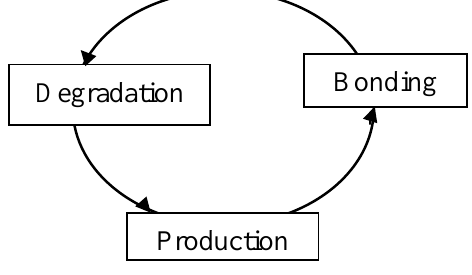
Degradation Figure 1. Generic processes in an autopoietic system, adapted from [6]